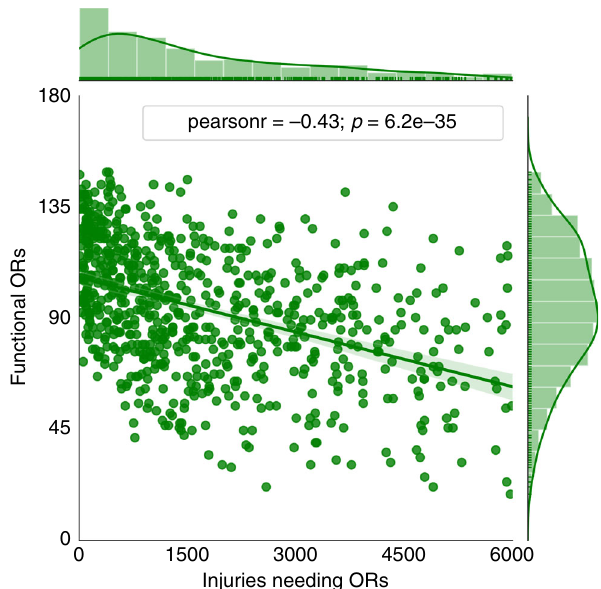
Fig. 4 1000 simulations of number of casualties needing surgical procedures in operating rooms (ORs) and number of functional operating rooms after the M 8.0 earthquake. The simulations result from probabilistic earthquake modeling (see “ Methods ” ) and capture uncertainty in ground shaking, building damage, injury occurrence, and hospital functionality. The linear trend indicates a negative correlation between the functional ORs and the number of injuries in the simulations. Source data are provided as a Source Data fi le.